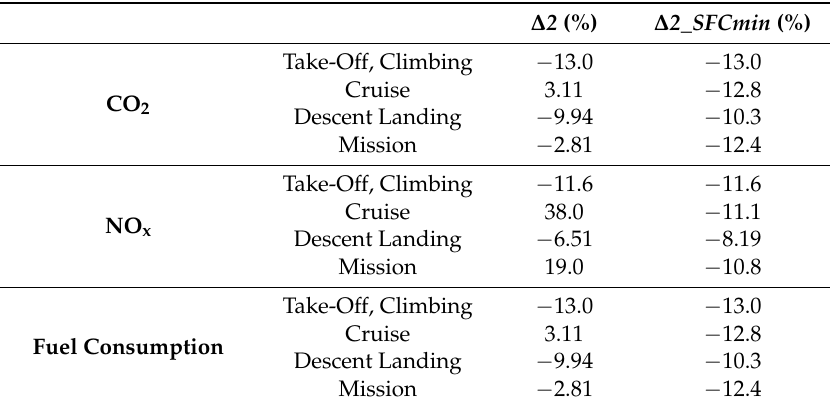
Figure 15. Specific fuel consumption for the two configurations. Table 4. Emissions results of Engine_2.